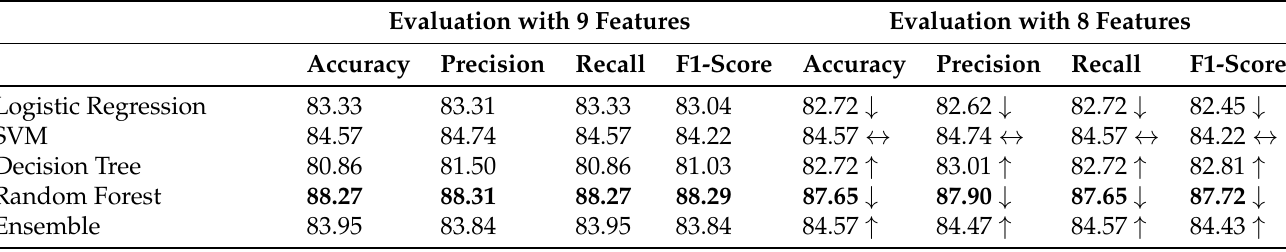
Table 3. Performance evaluation of the FPG-labeled